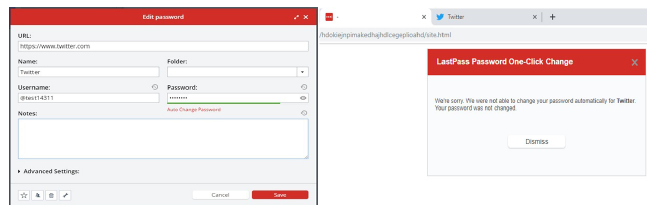
Figure A14. Auto-change password does not work in LastPass.